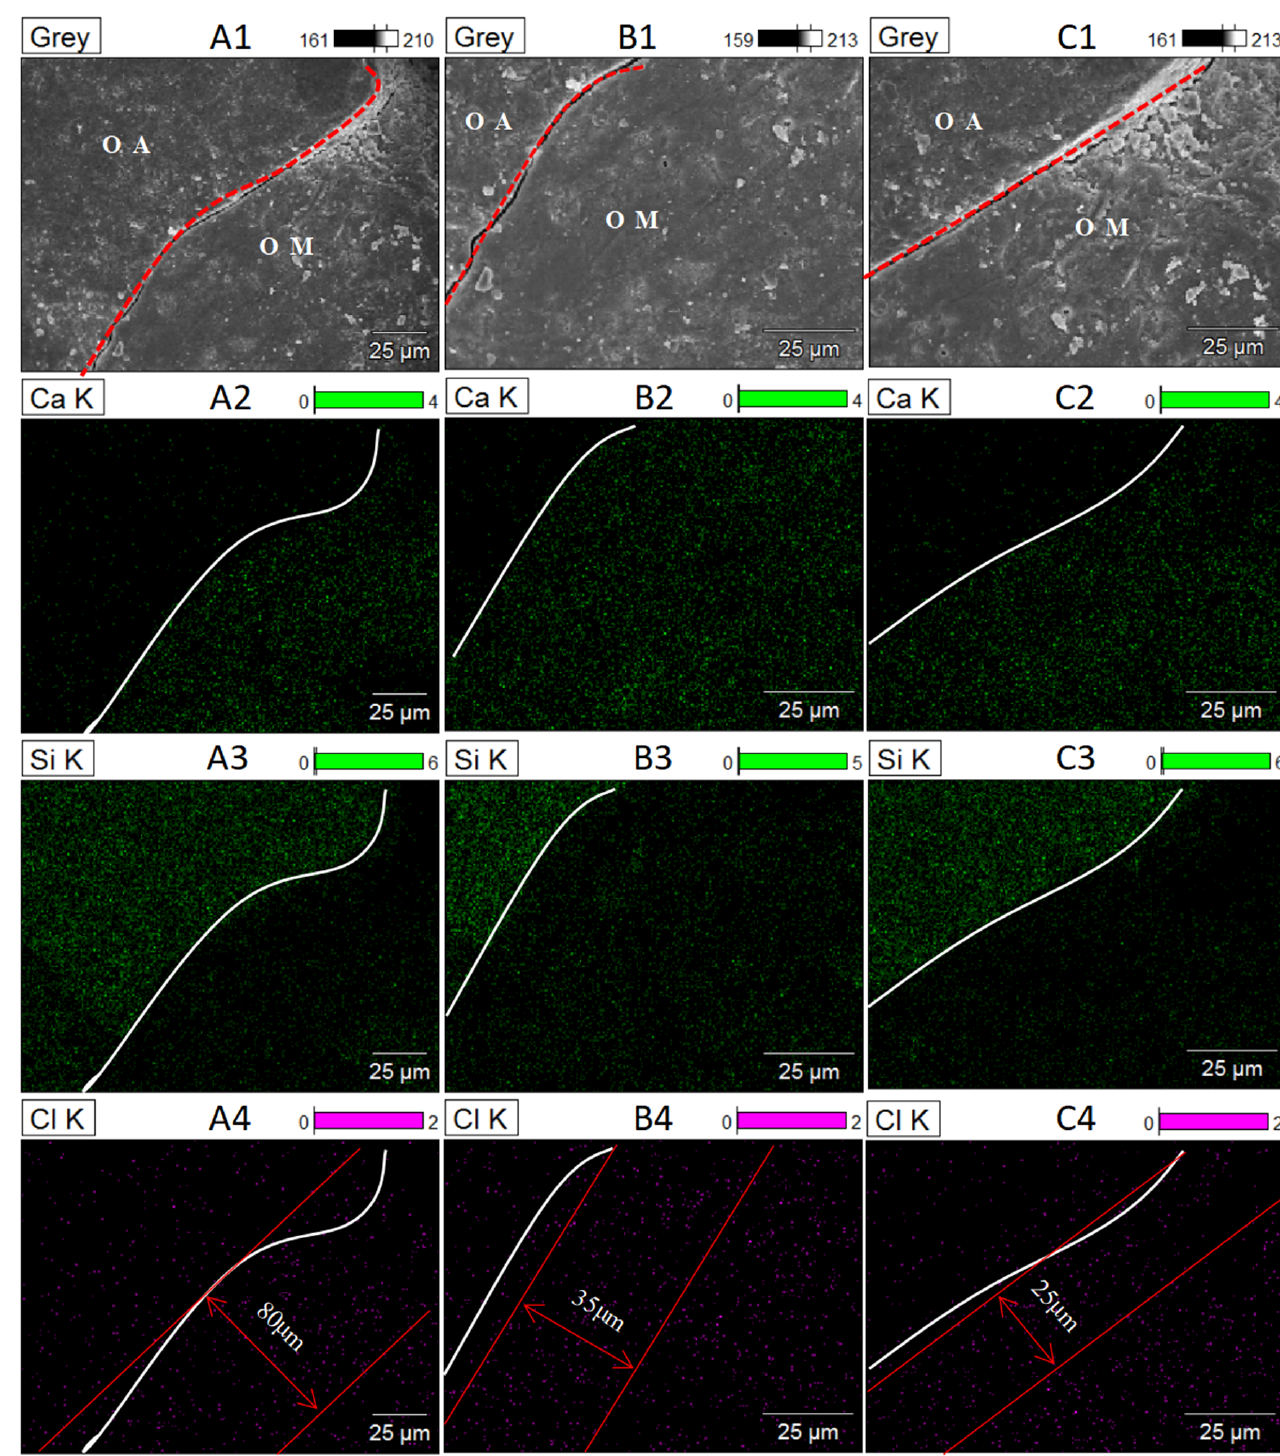
Figure 12. Surface features and the corresponding elemental mapping of OA-OM-ITZ after Cl − attack: ( A 1 , A 2 , A 3 , A 4 ) S-RCA recycled concrete, ( B 1 , B 2 , B 3 , B 4 ) C-RCA recycled concrete, ( C 1 , C 2 , C 3 , C 4 ) Si-RCA recycled concrete.